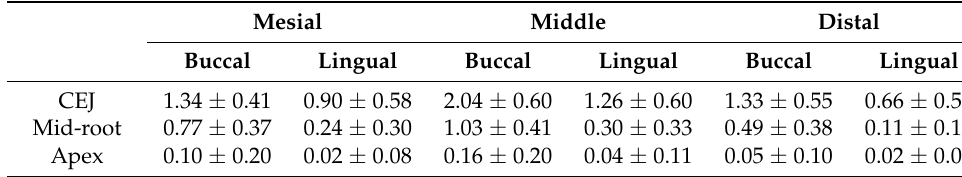
Figure 7. ( a ) Illustration showing horizontal alveolar bone loss. ( b ) Comparisons of horizontal bone loss at different sites. ( c ) Comparisons of buccal and lingual bone loss at mesial, middle, and distal sites. ( d ) Comparisons of buccal and lingual bone loss at CEJ, mid-root, and apex levels. * indicates p < 0.05, ** indicates p < 0.01, *** indicates p < 0.001. Table 2. Horizontal alveolar bone loss (mm) in missing group.